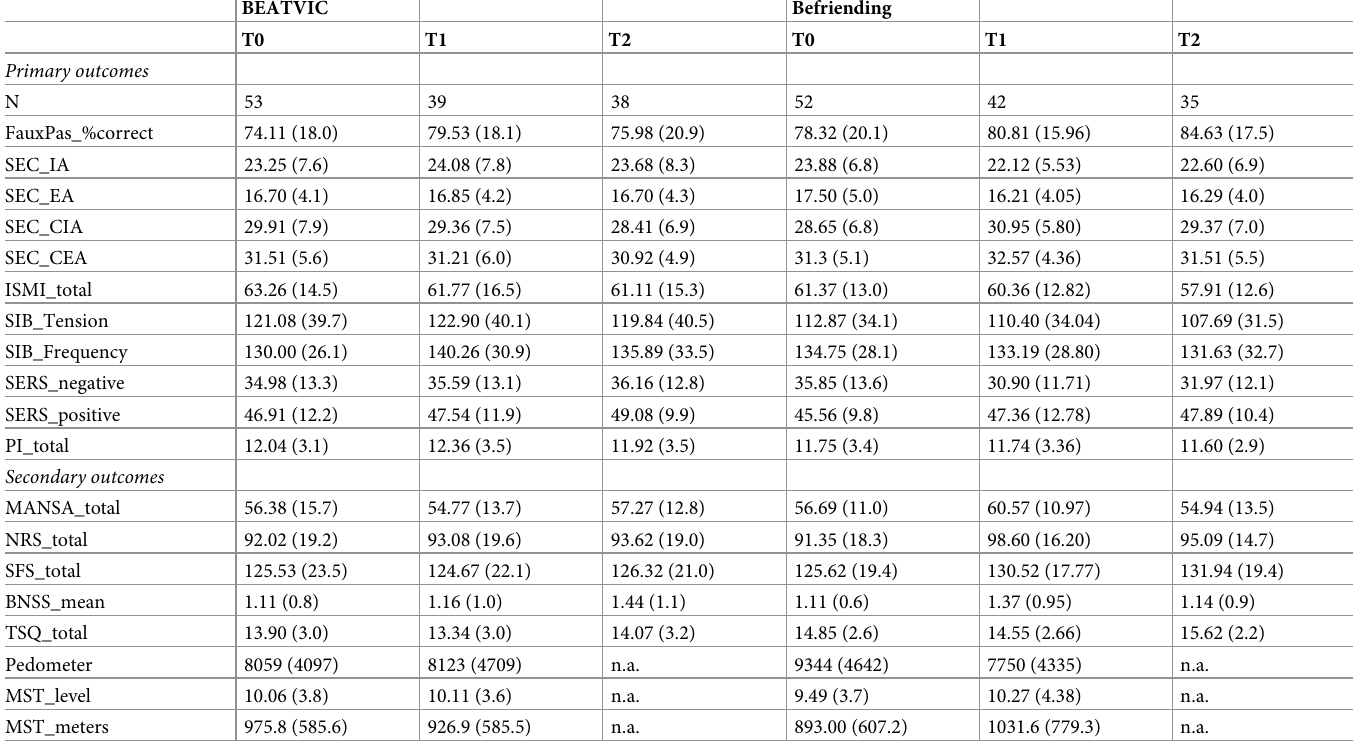
befriending). However, there was no significant difference between BEATVIC or befriending. No differences were found in primary and secondary outcomes between BEATVIC and befriending at post treatment and six months follow-up. For both conditions, victimization incidents either reduced over time, or did not occur, with very few new victimization incidents occurring during the period of the intervention and the 6 Table 3. Means and standard deviations of continuous primary and secondary outcome measures. BEATVIC